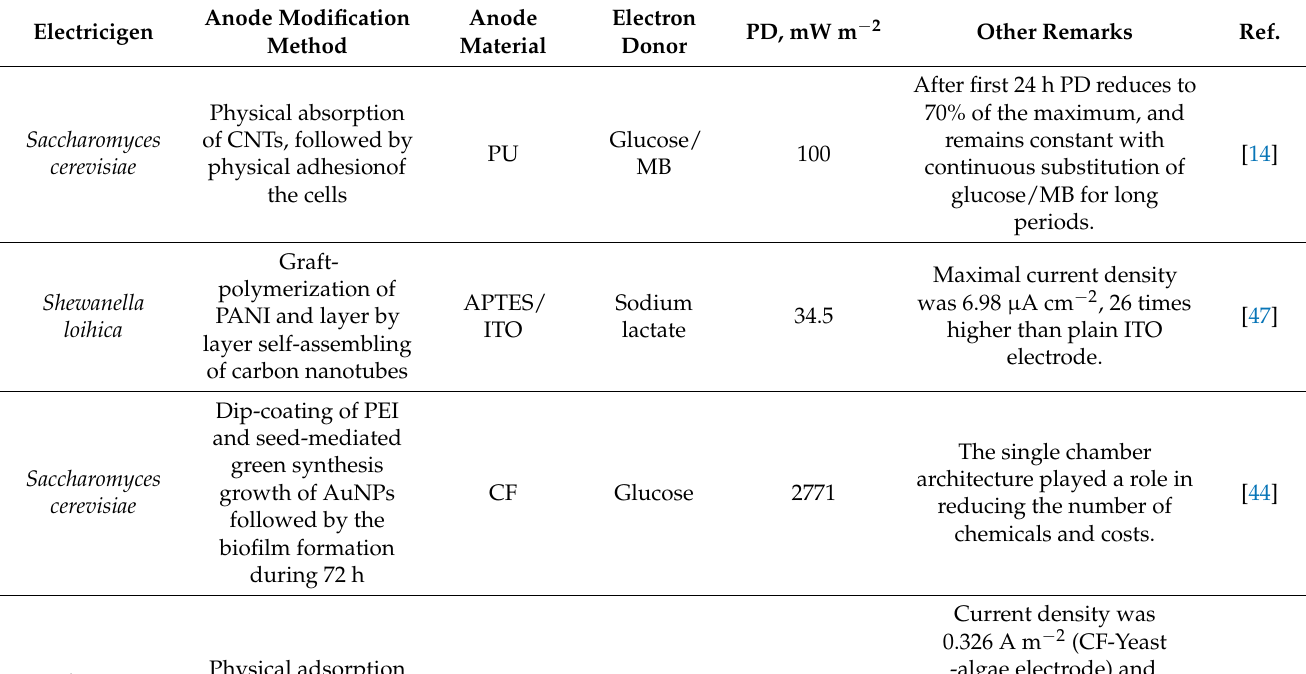
Table 1. The description of microbial biofuel cells (MFCs) anode modification method and MFC performance. Abbreviations provided below the